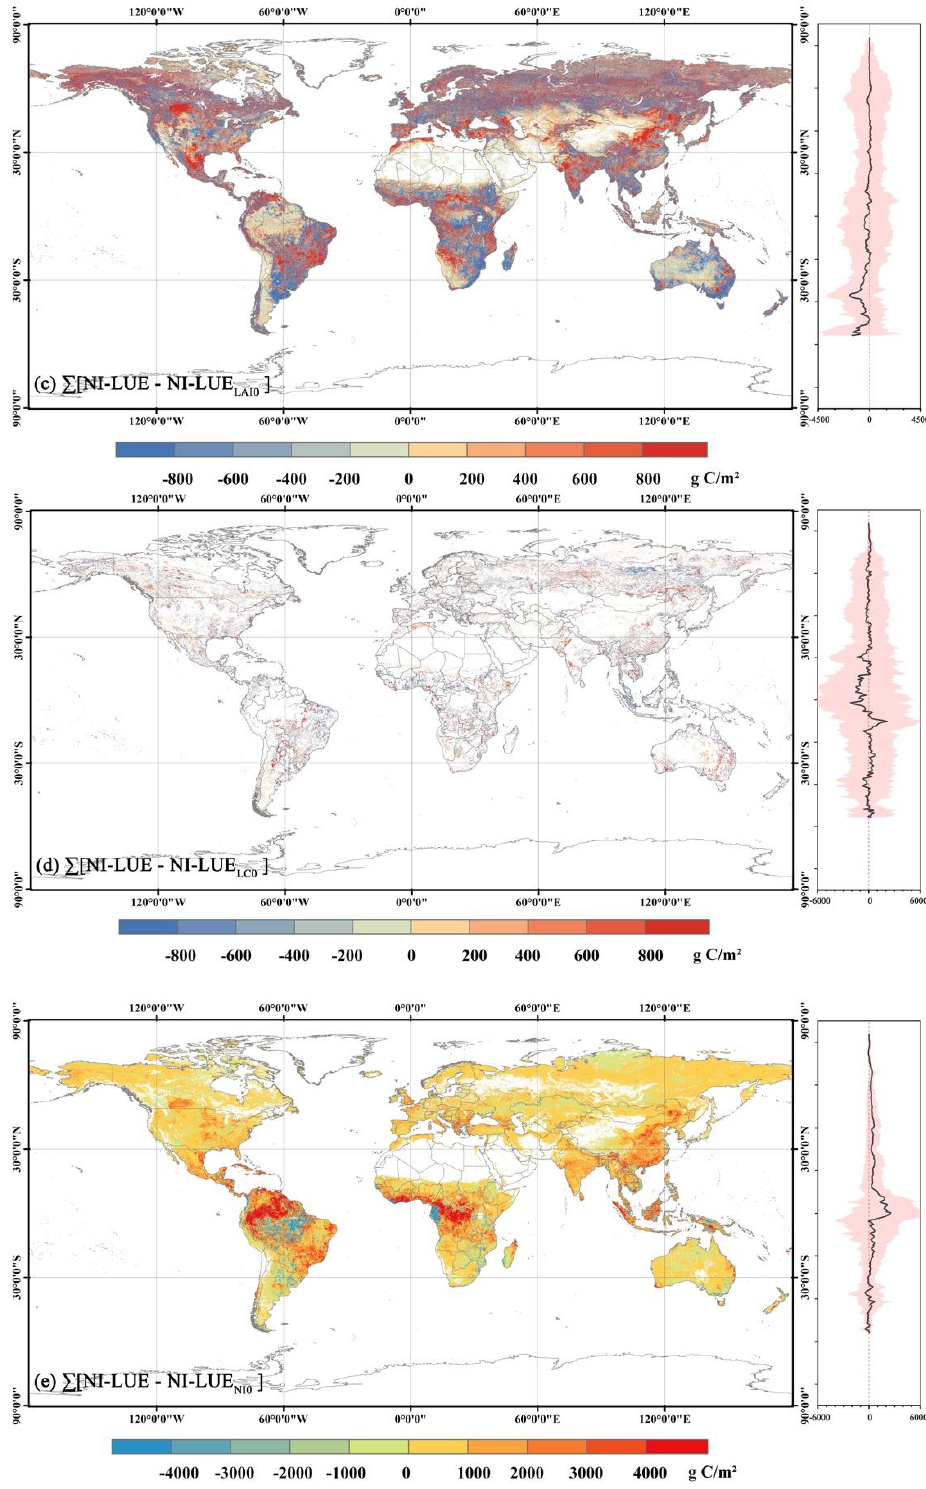
Figure 16. Spatial patterns of cumulative contributions of various variables to global annual GPP from 2001 to 2018. ( a ) Climate variables; ( b ) atmospheric CO 2 concentrations; ( c ) Leaf area index (LAI); ( d ) Land cover (LC); ( e ) Nitrogen index (NI). CI green , an index to characterize the canopy N concentrations (NI) in the NI-LUE model, was used to calculate dynamic ε max , which had a significant impact on global